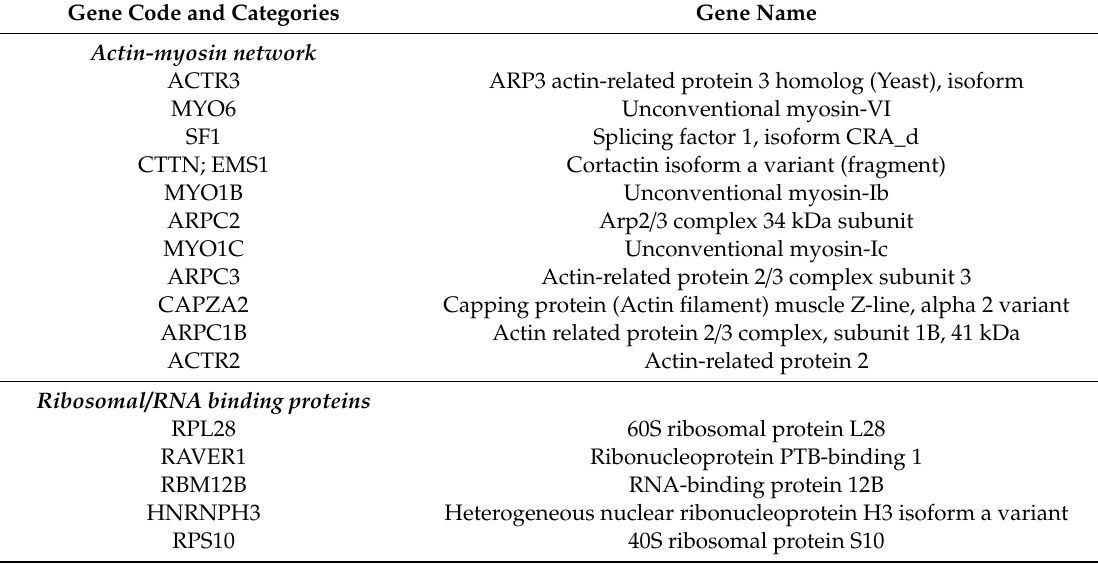
Table 5. Common host protein that interact with JCV LT-Ag and JCV Sm